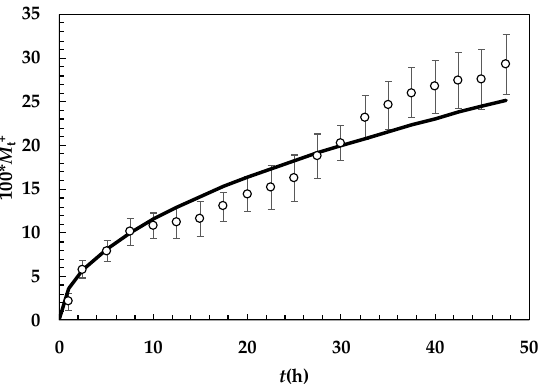
Figure 7. Time evolution of the dimensionless amount of myoglobin released from a cylindrical 20C hydrogel ( M t+ is the ratio between the amount of drug released at time t and the amount released after an infinite time). Open circles indicate experimental data while the solid line is Equation (14) best fitting. Vertical bars represent datum standard error.